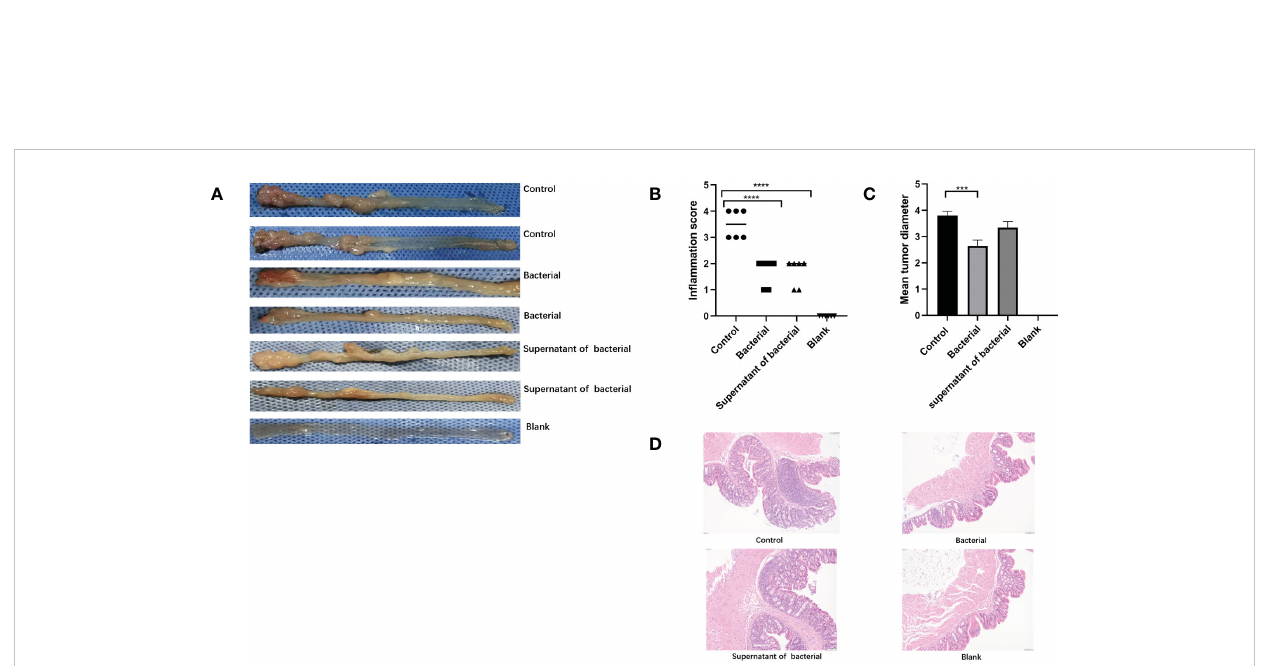
FIGURE 4 Induction of mice models of CRC and in fl ammatory scores. (A) Intestinal tumor tissues in the mice of the control, bacteria, supernatant, and blank groups. (B) Comparison of intestinal in fl ammatory score among different groups. (C) Comparison of tumor length among different groups. (D) HE fi ndings among different groups. The data are described as mean ± SEM and compared using one-way ANOVA. ***P<0.0005, and ****P<0.0001.